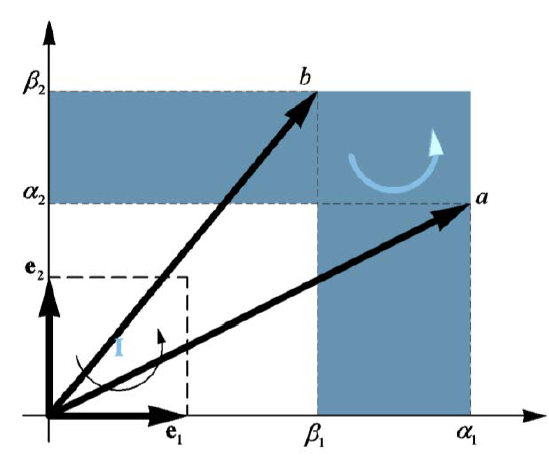
Figure 7: The extension of vector a along vector b provides the geo- metric interpretation of the outer product a ∧ b .